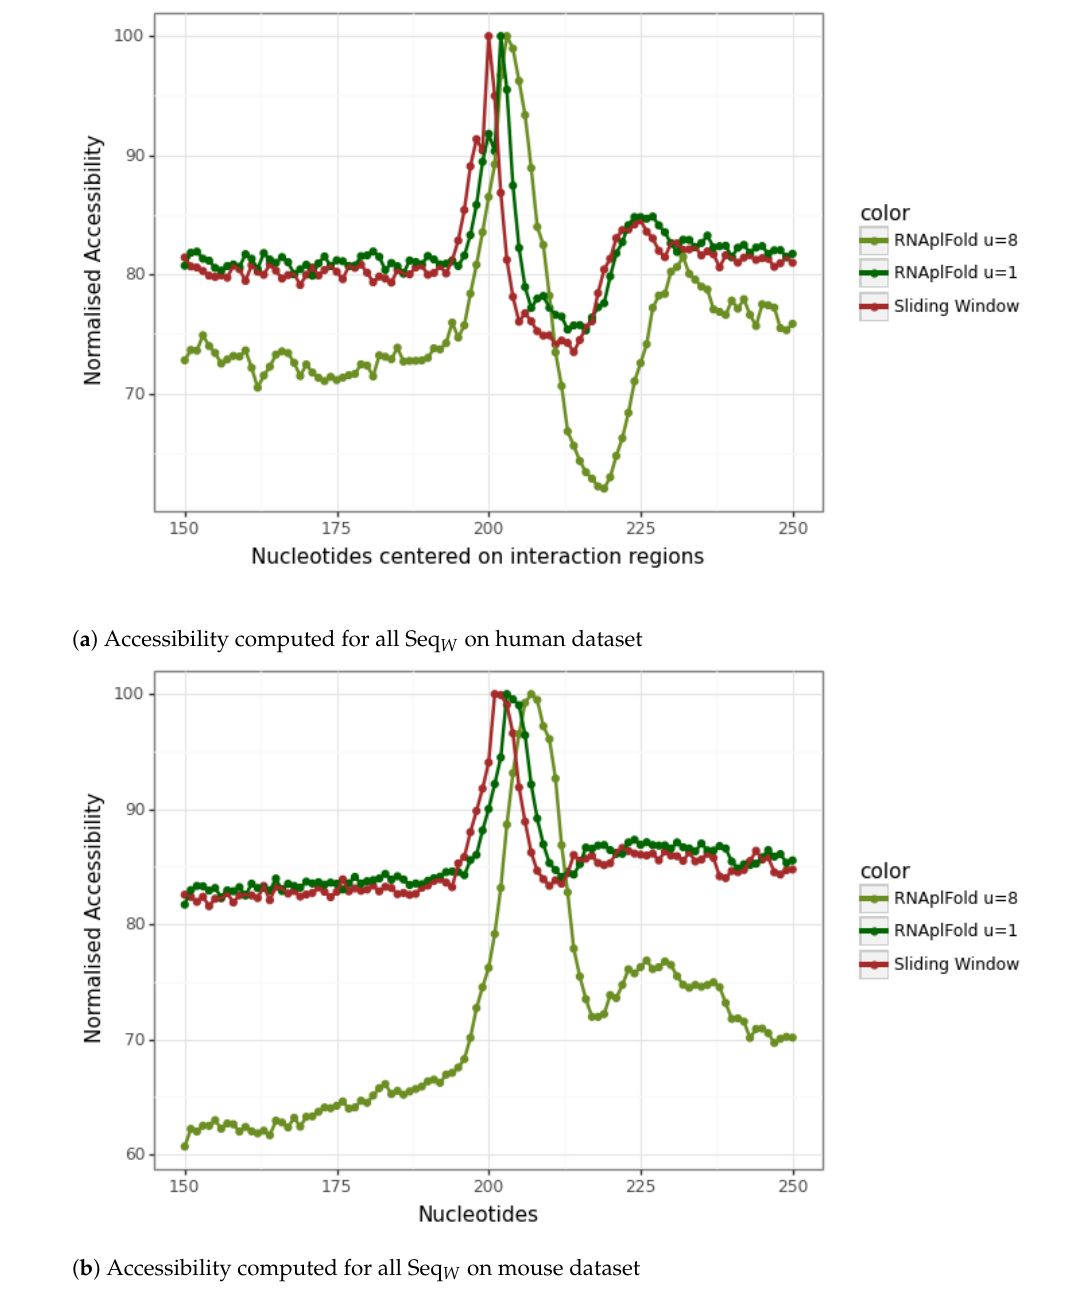
Figure 4. Accessibility computed for all Seq W on mouse and human datasets. In red is the accessibility when considering only the optimal structure with a sliding window. In dark green and in olive green are the accessibility computed with RNA PL F OLD with an accessible window u of 1 and